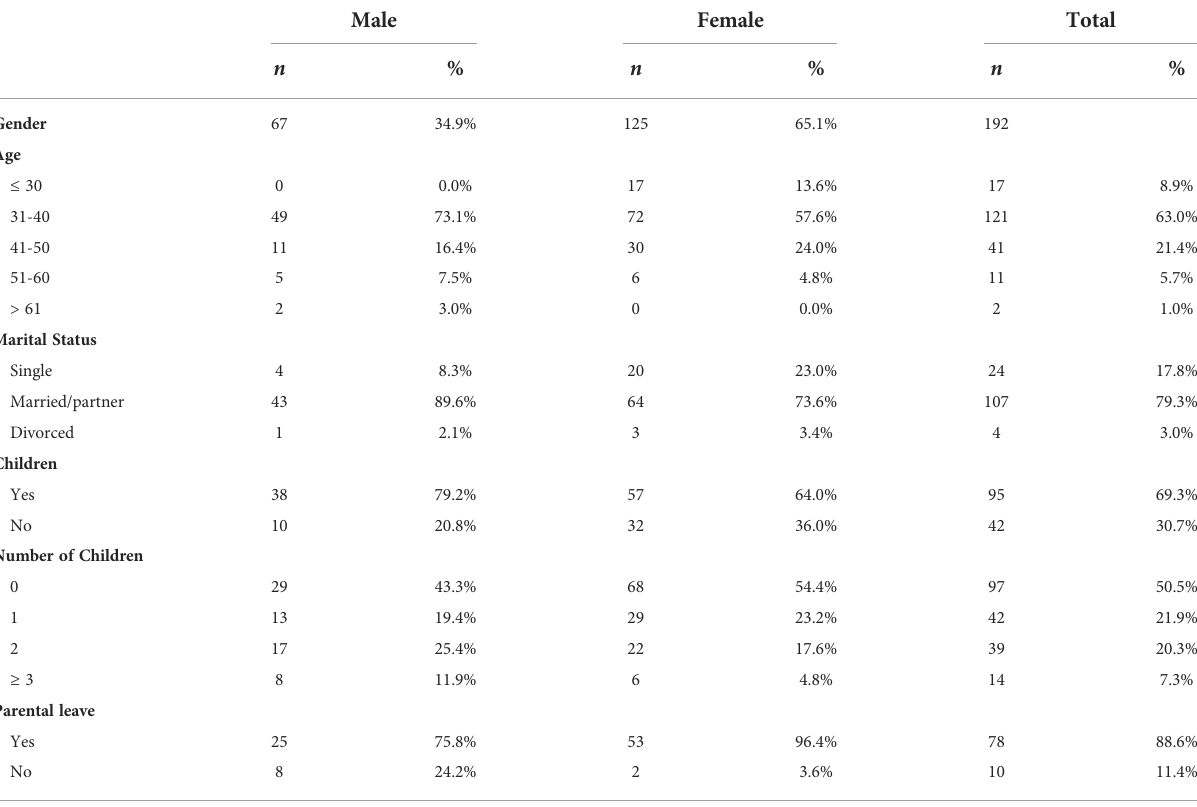
TABLE 1 Demographic